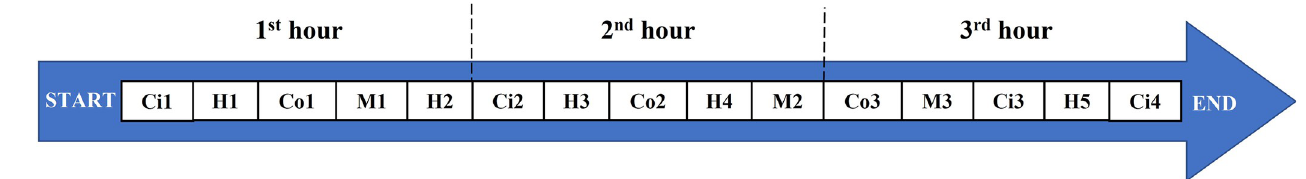
Fig 1. Chronologic order of road sectors throughout the driving itinerary. Each participant followed the same itinerary, which included city (Ci), highway (H), country (Co) and mountain (M) roads.